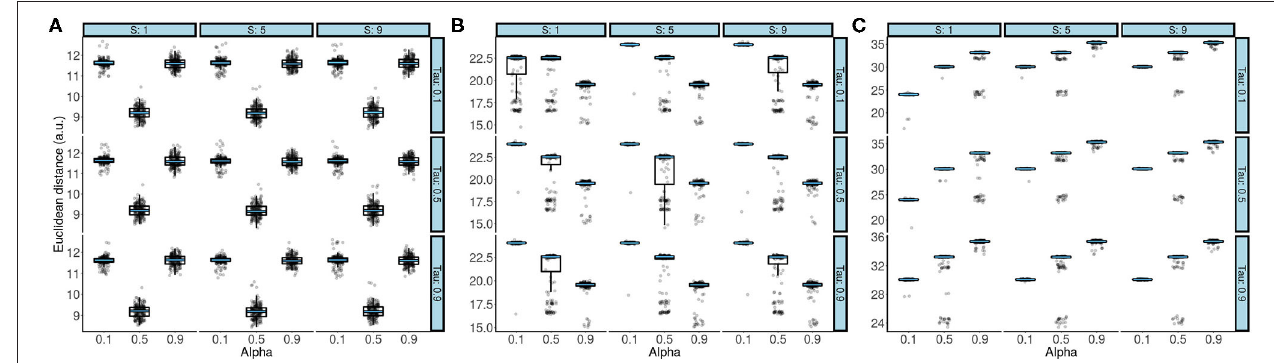
FIGURE 2 | Boxplots overlaid with raw data showing the effect of ( τ , α , S ) on the Euclidean distance after passing 50 trajectory waypoints (A) , 100 trajectory waypoints (B) , and 200 trajectory waypoints (C) . The black line of the box plot denotes the median value. The upper and lower bound of the boxplot denotes the 1st and 3rd quartile of the dataset. The boxplot whiskers denote the 1.5* Inter quartile range (IQR). The superimposed blue line on the boxplots denotes the median and has been added for clarity purposes. In all three panels, the α parameter had the strongest effect on Euclidean